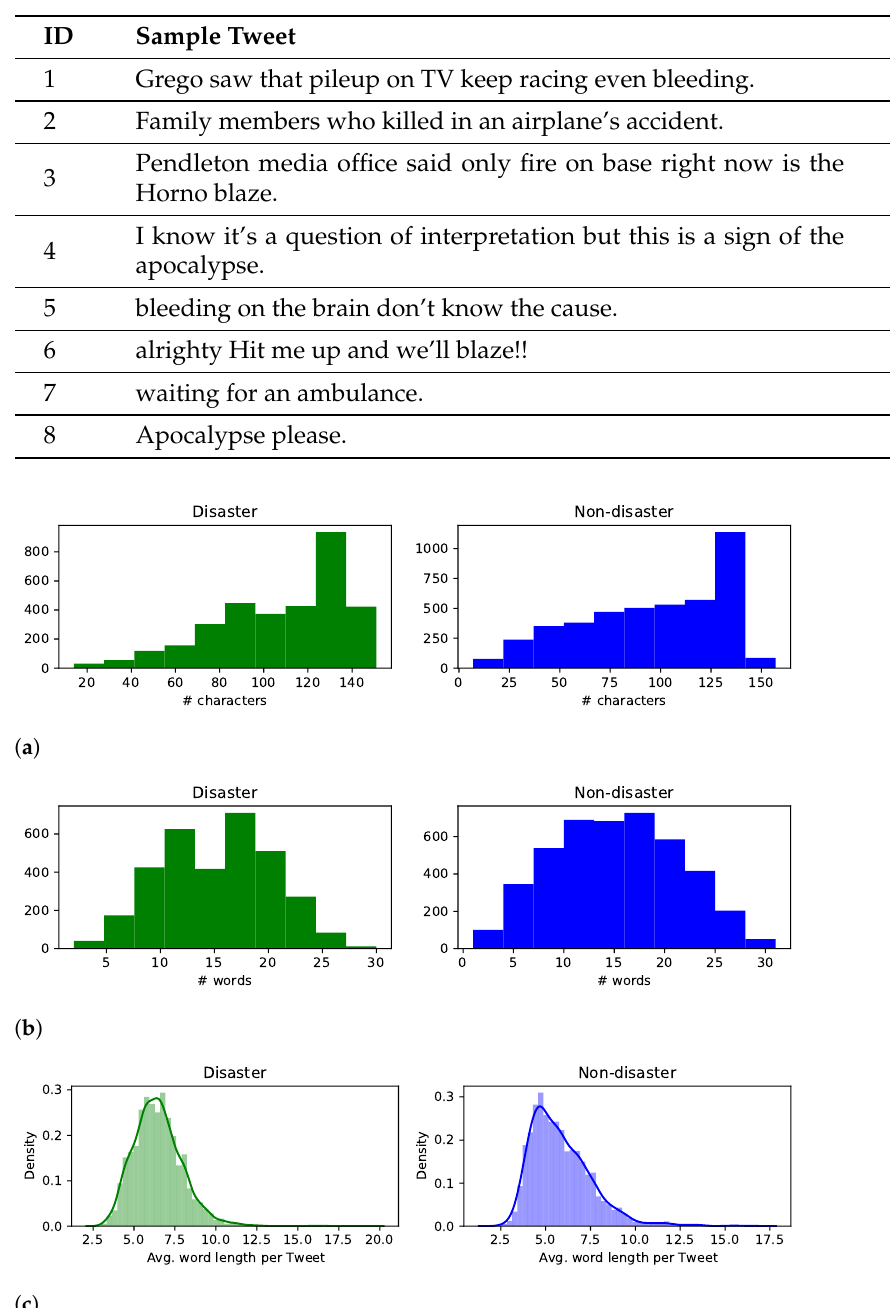
Table 1. Disaster Tweets dataset samples. A + sign indicates a positive sample, and a − sign indicates a negative sample.